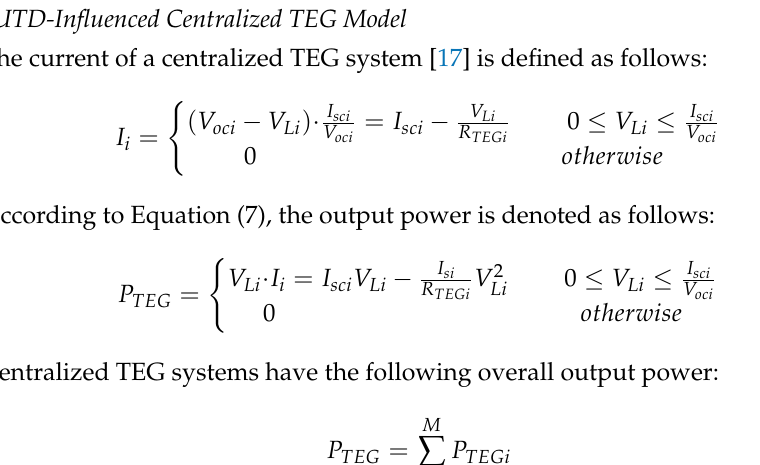
Figure 2. The TEG module’s intrinsic architecture and loaded circuit.